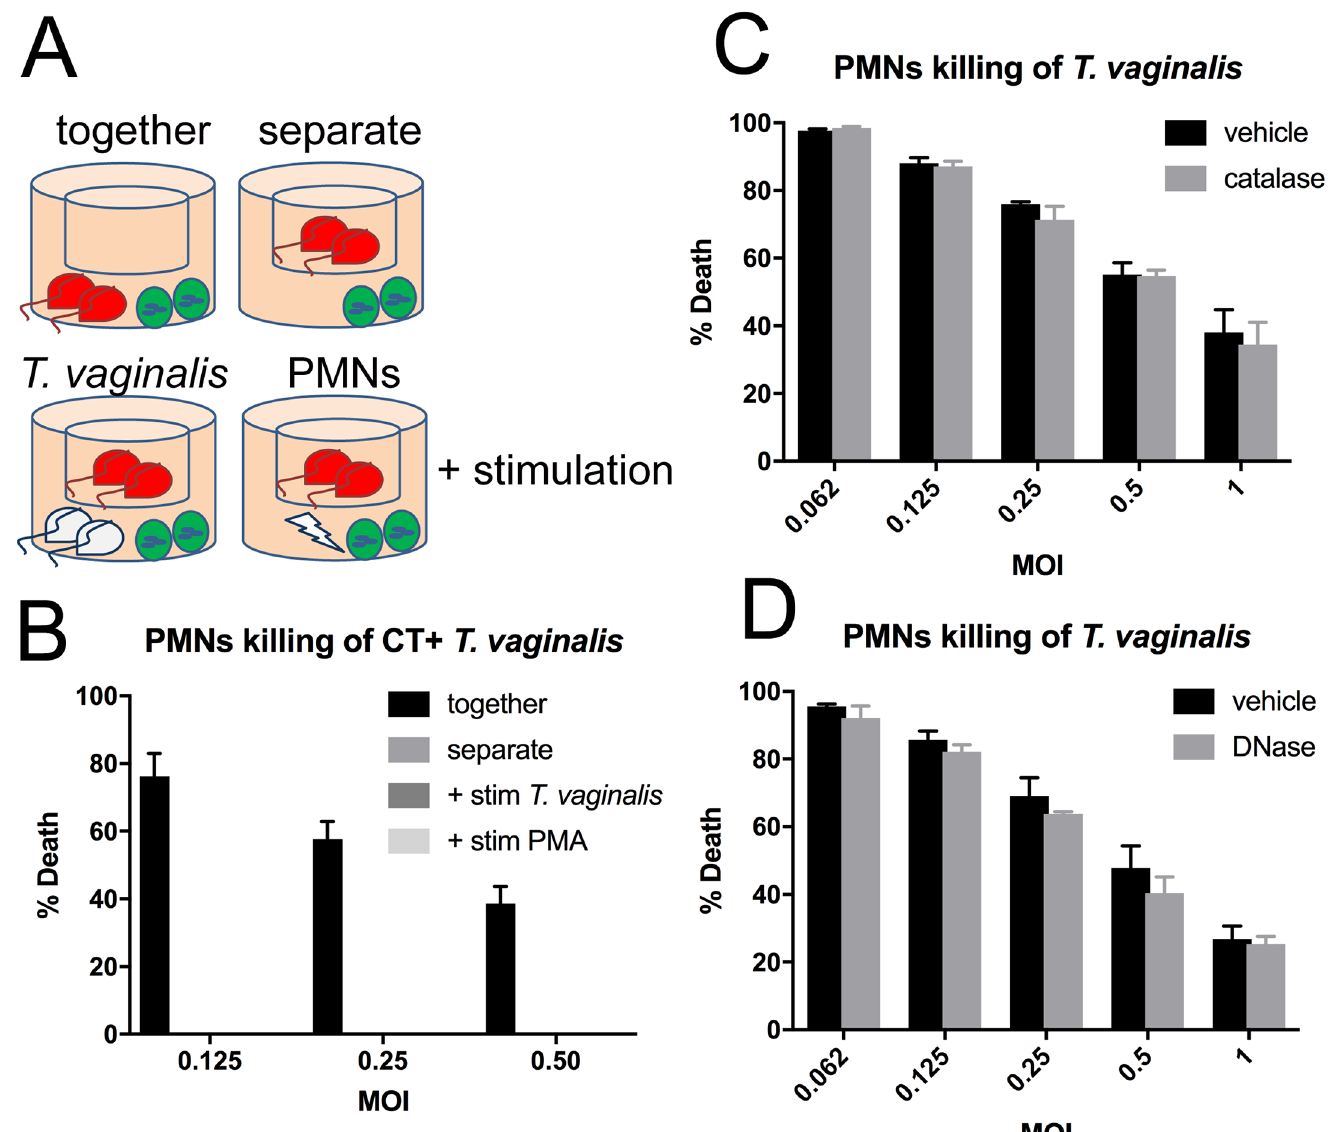
Fig 2. PMN killing of T . vaginalis is contact-dependent. (A) and (B) T . vaginalis and PMNs were labelled with CT or CFSE, respectively, and cocultured at the indicated MOI in trans -well plates for 2 hours either together in the bottom well or separate, with T . vaginalis in the top well and PMNs in the bottom well. Cultures were either incubated in the absence or presence of stimulation with 100 nM PMA (lightning bolt symbol) or unlabeled T . vaginalis (white parasites) added at an equivalent MOI in the bottom well. (C) T . vaginalis cytotoxicity assays were performed as described in Fig 1, in the presence of (C) 20,000 U/ml catalase or vehicle control (PBS) or (D) 100 U/ml DNase or vehicle control (HBSS). All data are represented as mean ± SD of triplicate wells and representative of 3 donors and 3 independent experiments. CFSE, Carboxyfluorescein succinimidyl ester; CT, Cell Tracker; HBSS, Hank’s Balanced Salt Solution; MOI, multiplicity of infection; PBS, phosphate-buffered saline; PMA, phorbol-myristate acetate; PMN, polymorphonuclear cell.